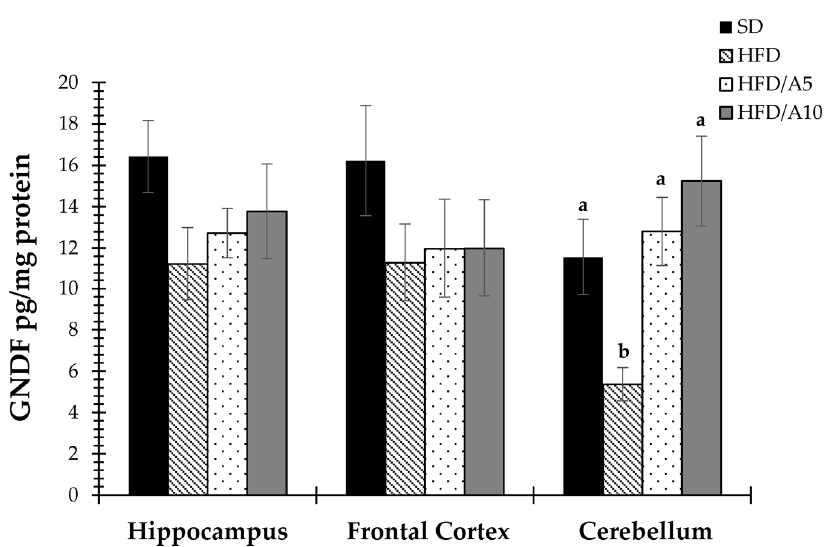
Figure 4. Effects of fructans on glial-derived neurotrophic factor (GDNF) levels in the hippocampus, frontal cortex and cerebellum of mice fed with standard diet (SD); high-fat diet (HFD); high-fat diet with agave fructans 5% (HFD/A5); high-fat diet with agave fructans 10% (HFD/A10). One-way ANOVA and Tukey contrasts were performed to compare differences among groups. The data are represented as the mean with their standard errors of the mean (SEM). N = 10. Mean values with unlike letters (a,b) were significantly different ( p < 0.05).